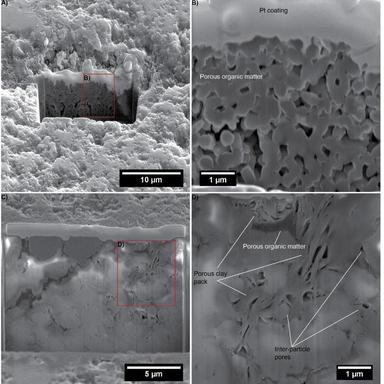
SEM image from an ion-milled polished sample of Marcellus shale. A) Overview of the sample surface and the ion milled trench excavated within a porous organic particle. B) Detail of the porous organic particle showing and interconnected pore network of pores with sizes of up to few hundred nm. C) Overview of the sample surface and the ion milled trench excavated within an organic lean portion of the sample. D) Detail of inter-particle pores with elongated and triangular shapes occurring at the junction betw